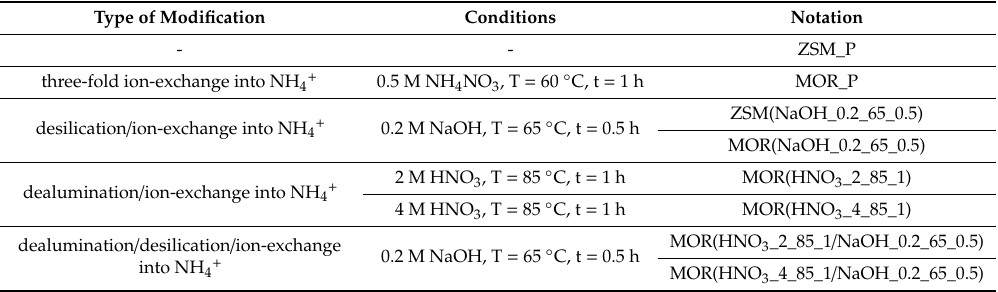
Table 1. Detailed procedures and conditions of zeolite modifications with sample